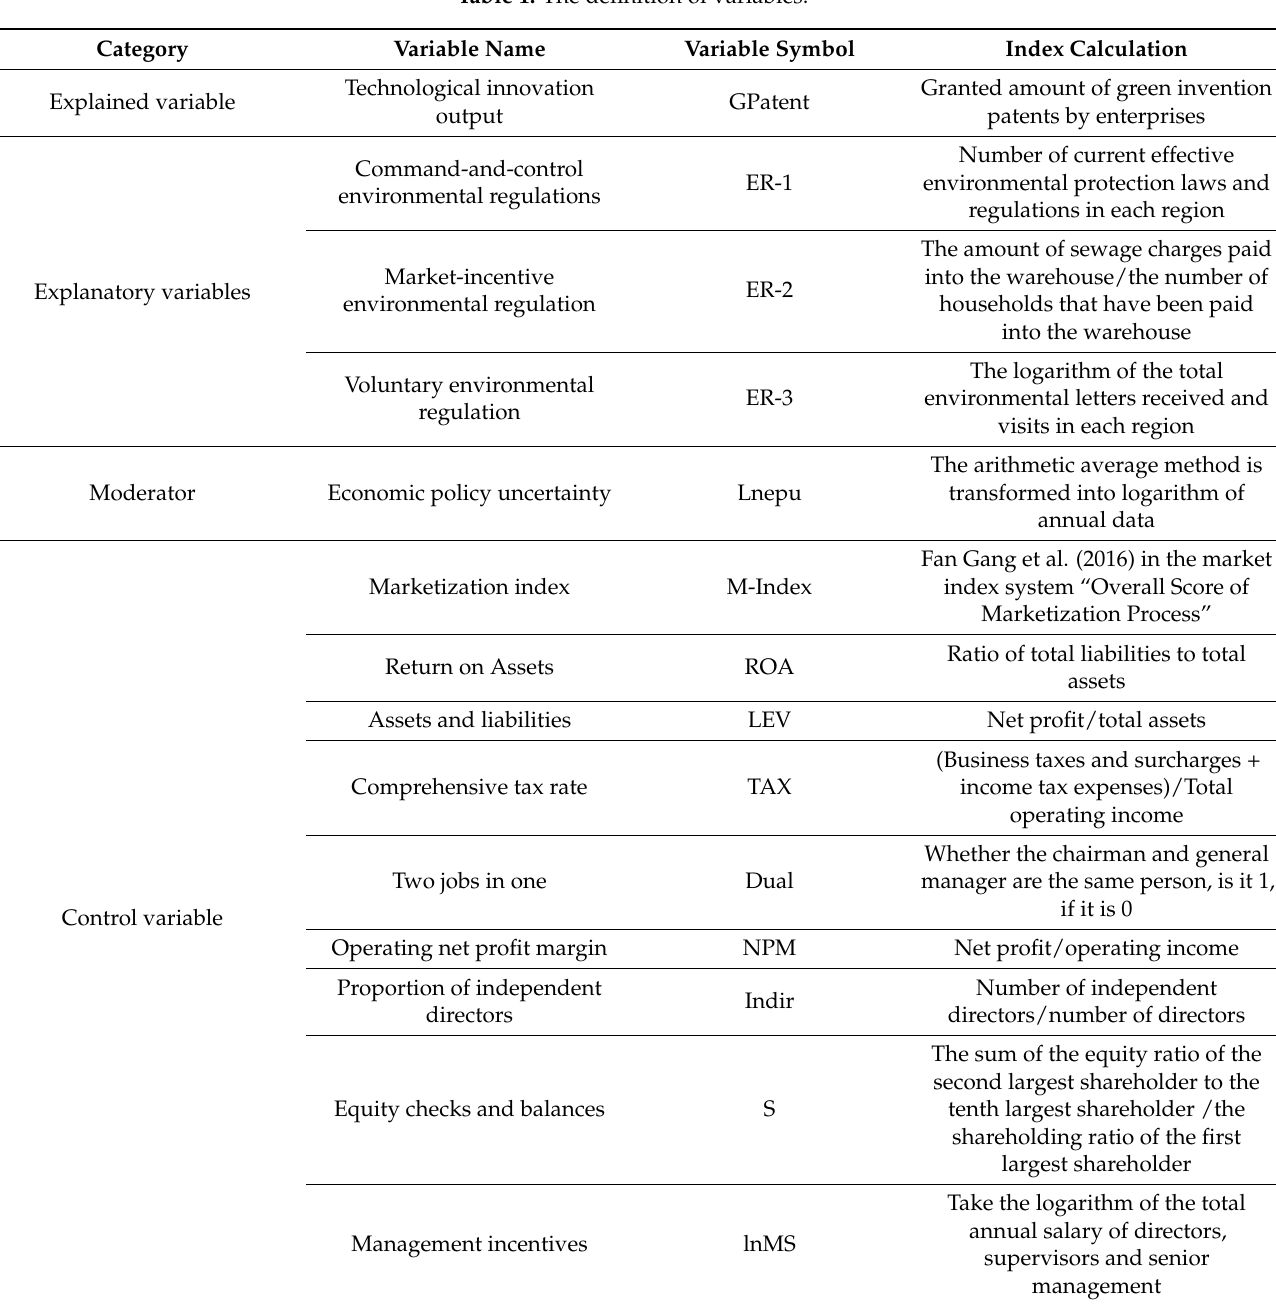
Table 1. The definition of